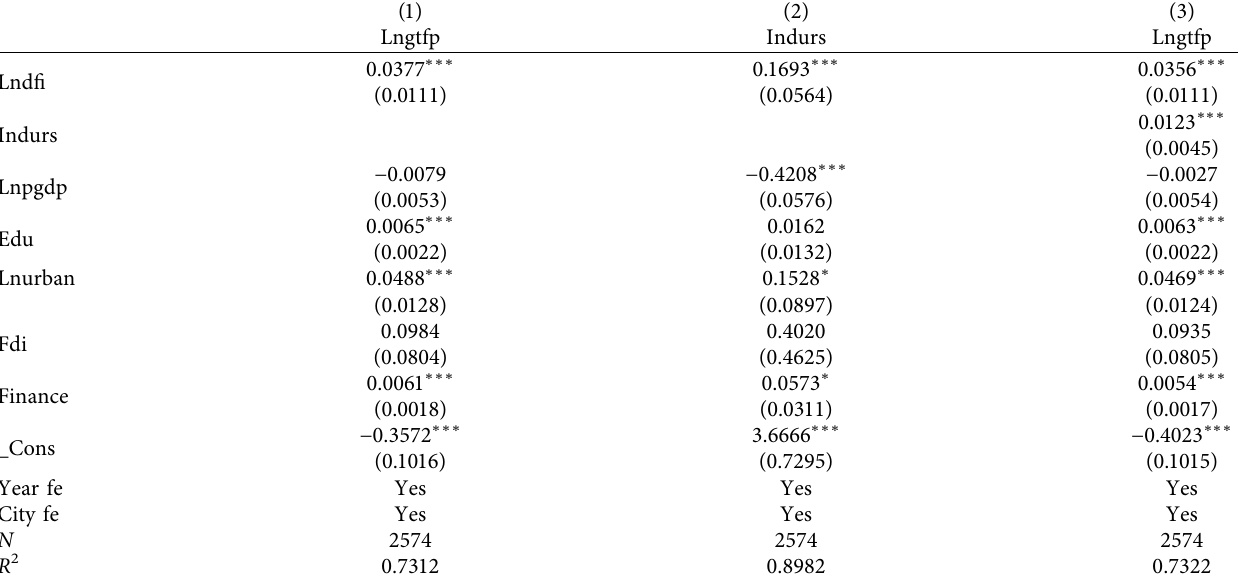
Table 6: External mechanism of digital finance influencing green development.